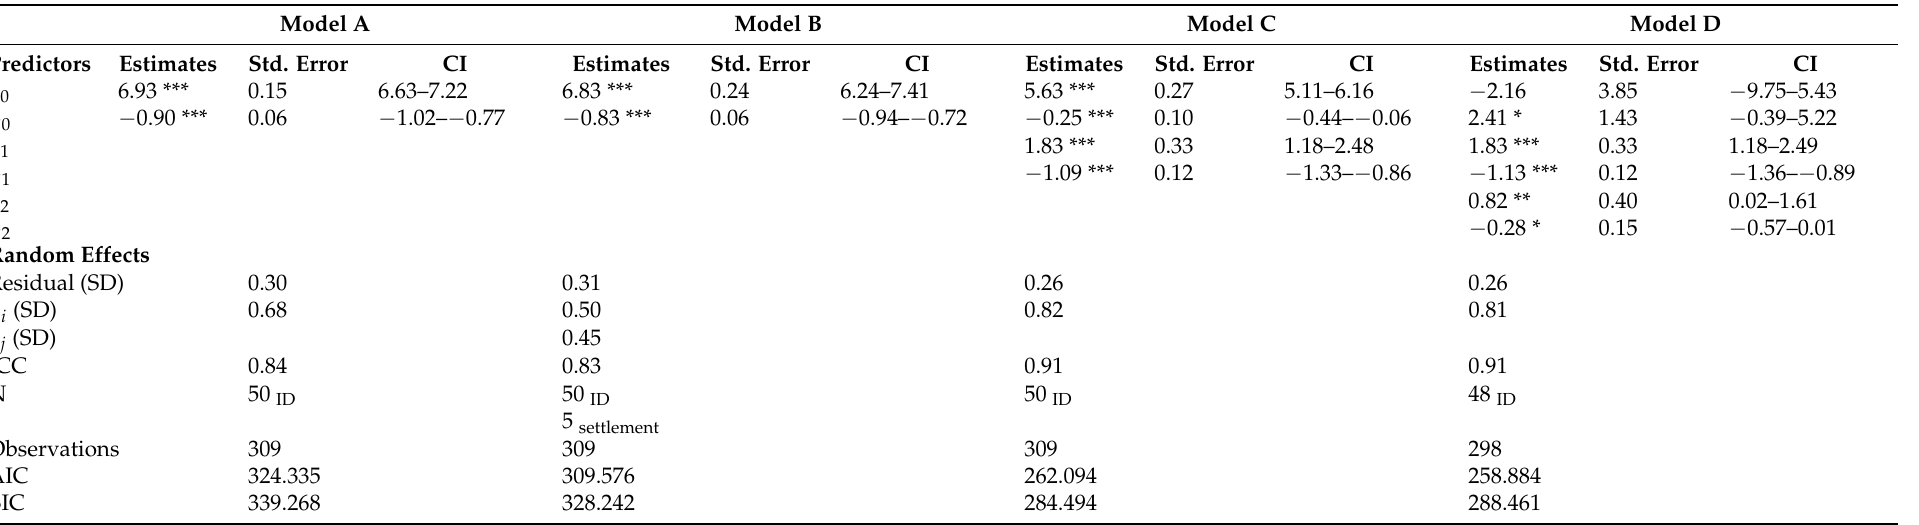
Table 5. Model outputs. (Data source: [41], January data